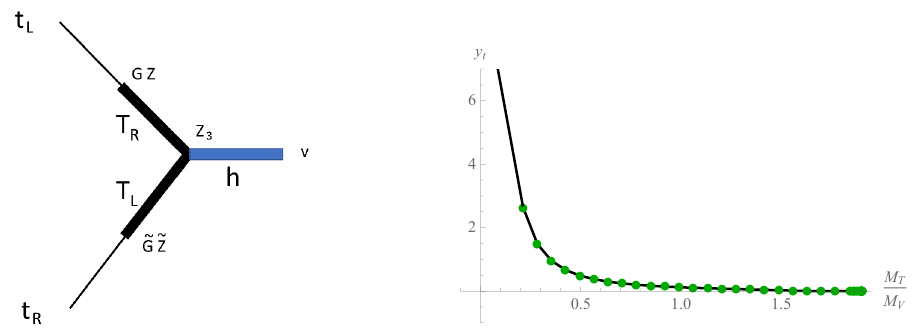
Figure 1. Left: The top Yukawa coupling ( y t ) vertex diagram. Right: Yukawa coupling as function of the top partner mass in the A 2 sector of the SU(4) gauge theory (with g = ˜ g =